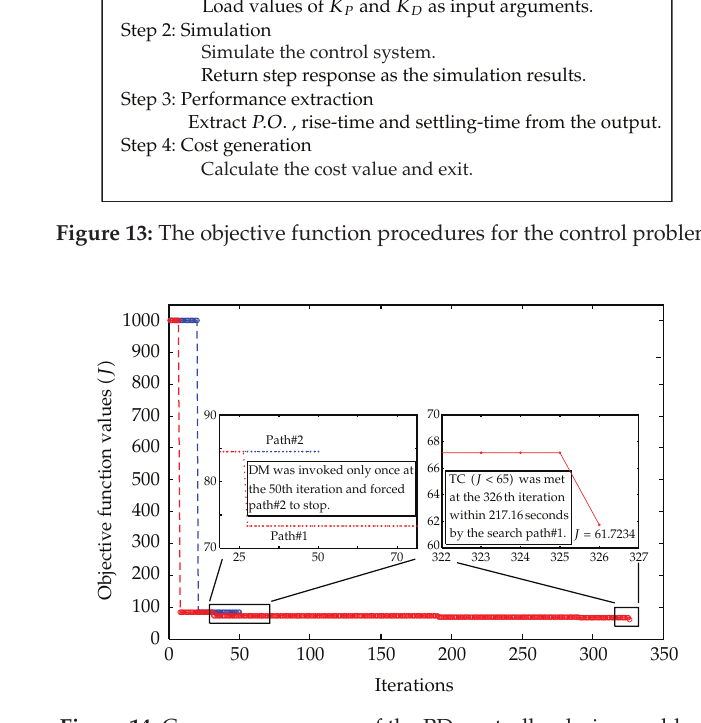
Figure 14: Convergence curves of the PD-controller design problem.